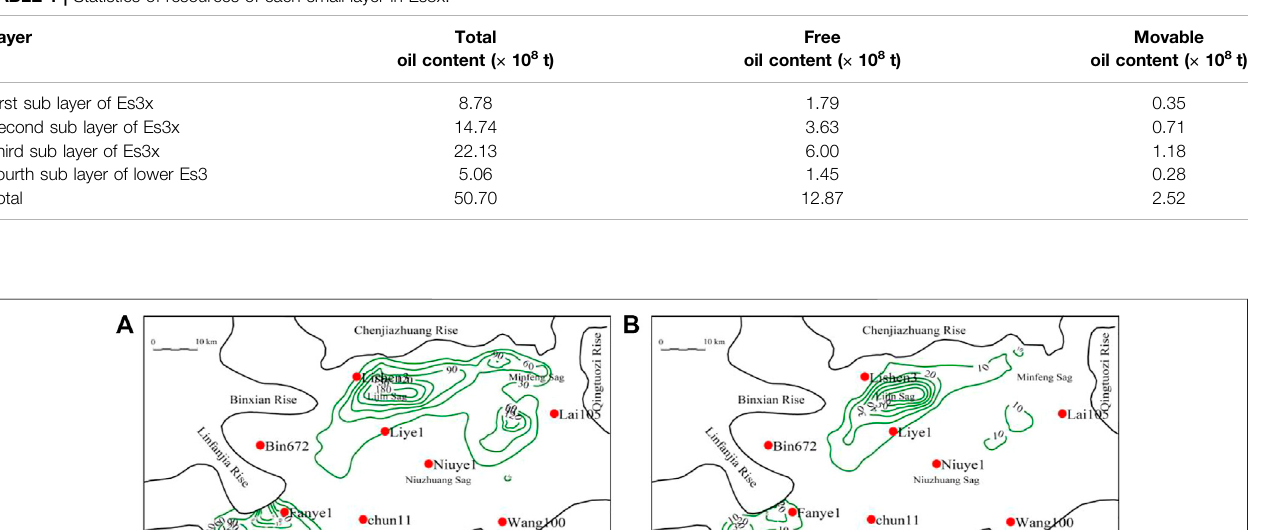
Frontiers in Earth Science |